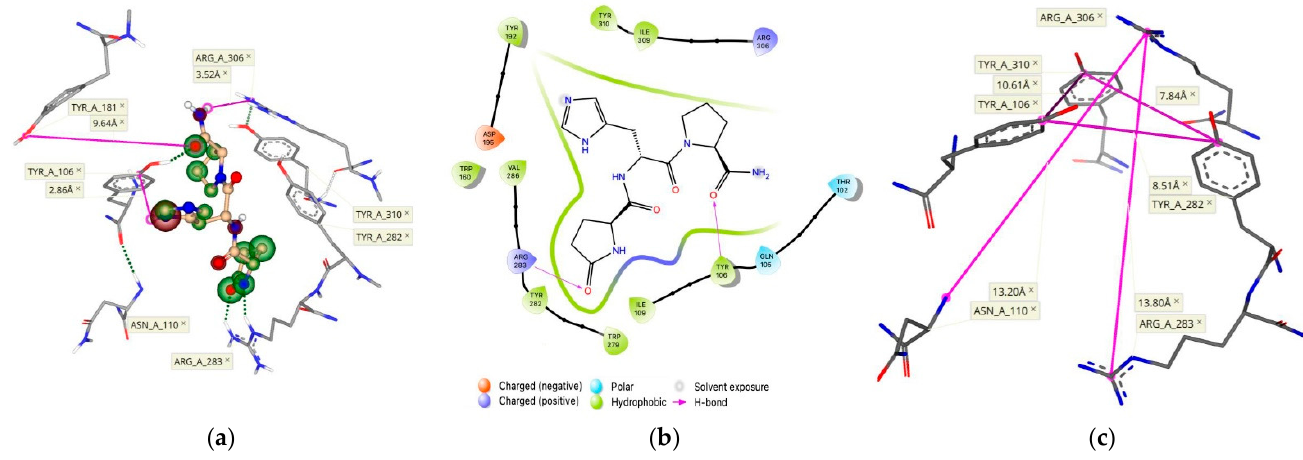
Figure 2. ( a ) TRH docked within the TMB of its receptor with an estimated binding affinity in the nM range. Hydrogen bonding is represented as green dashed lines, whereas the size and color of the coronas surrounding each ligand atom represent the degree of contribution of that atom to the binding score (green indicates favorable, red denotes unfavorable). ( b ) This binding is also outlined in a 2-D pharmacophore model. ( c ) The equidistant position of the Tyr residues on each of the three α -helices, as well as the vertical boundaries of the binding pocket are outlined with measurements made between key residues.